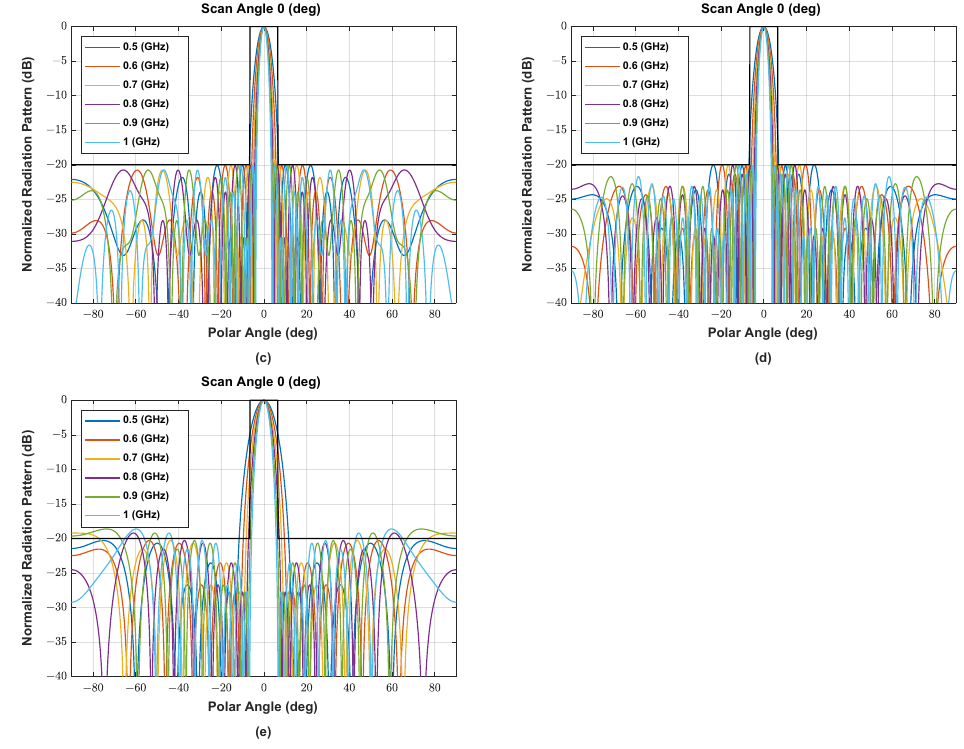
Figure A1. The beam pattern of symmetric NUSLA using ( a ) MORELA, ( b ) QPSO, ( c ) FA, ( d ) SSA, and ( e ) MALO in case for θ 0 = 0°.